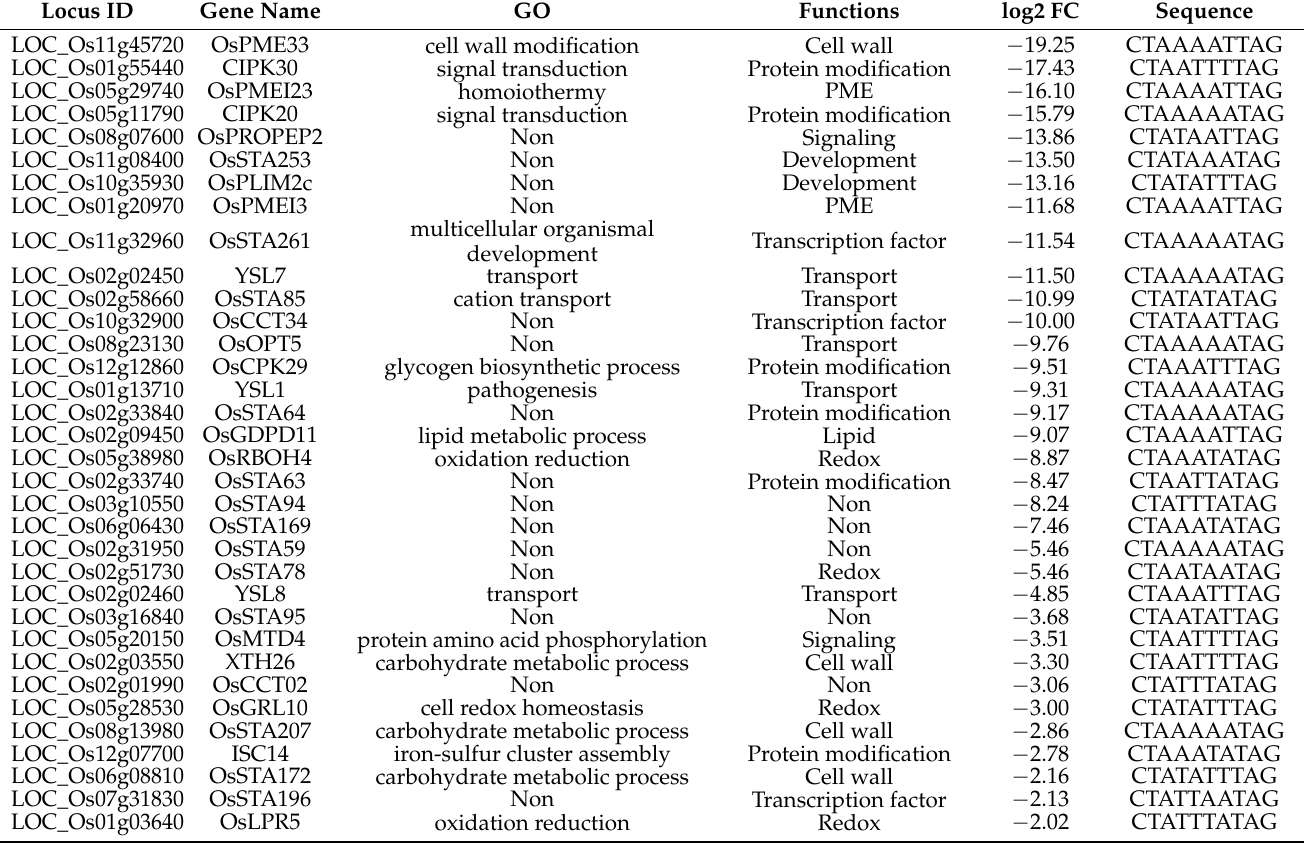
Table 2. The promoter analysis of anther downregulated genes in OsMADStri